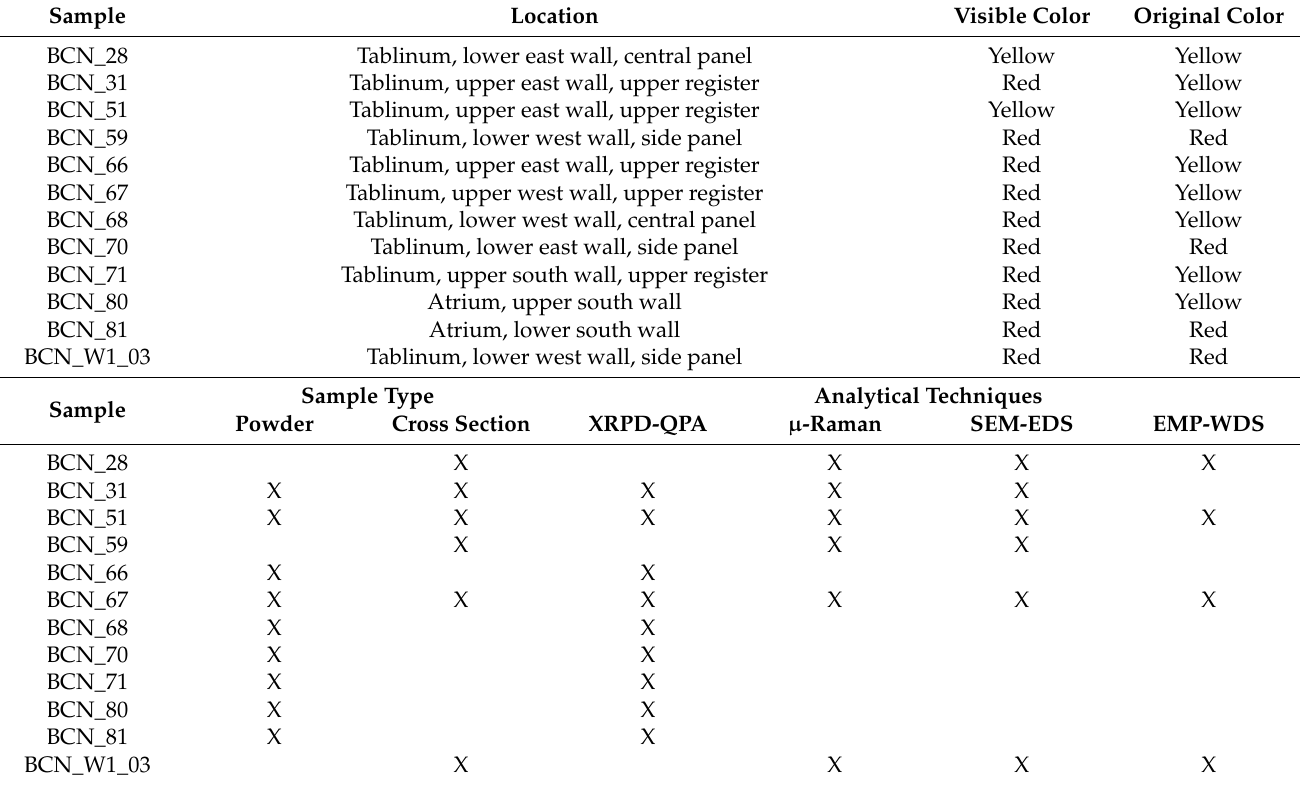
Table 1. List of the analyzed samples. Sample labels, location, and visible and hypothesized colors for each sample are reported, together with sample type and applied analytical